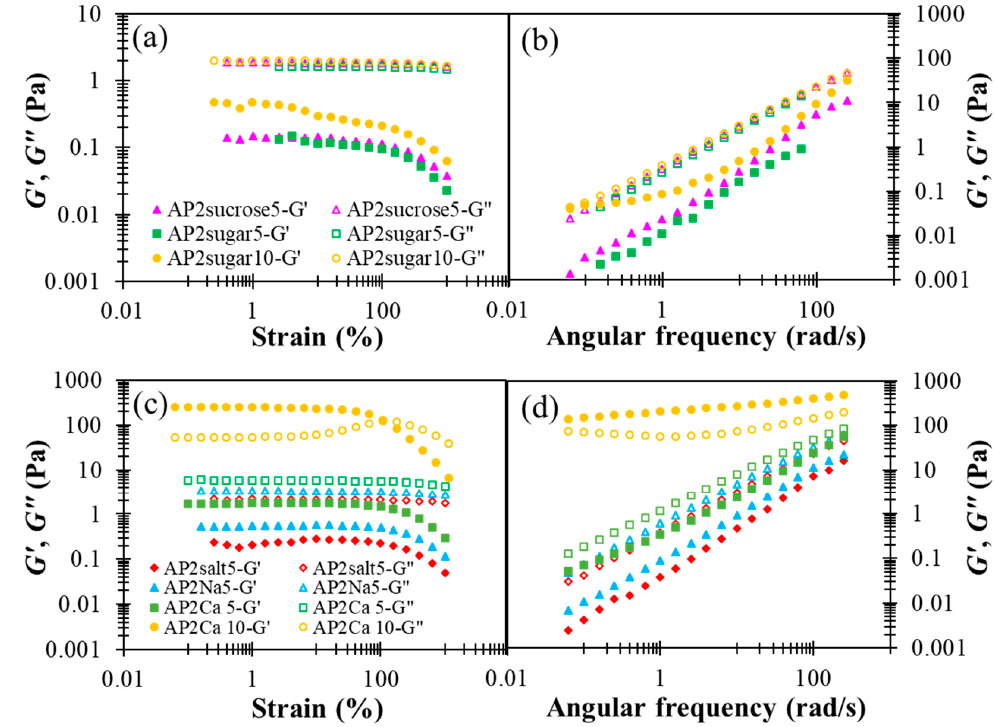
Figure 5. The effect of designated basic food ingredients (sugars and cations) incorporated AP2 based formulation on shear storage modulus (G’) and shear loss (G”) modulus profiles with respect to percentage strain and angular frequency alterations: ( a ) strain sweep of sugar or sucrose incorporation, ( b ) frequency sweep of sugar or sucrose incorporation, ( c ) strain sweep of monovalent sodium (table salt or chemical grade sodium chloride) and divalent calcium, ( d ) frequency sweep of monovalent sodium and divalent calcium; BFIs concentrations are either 5 or 10%.